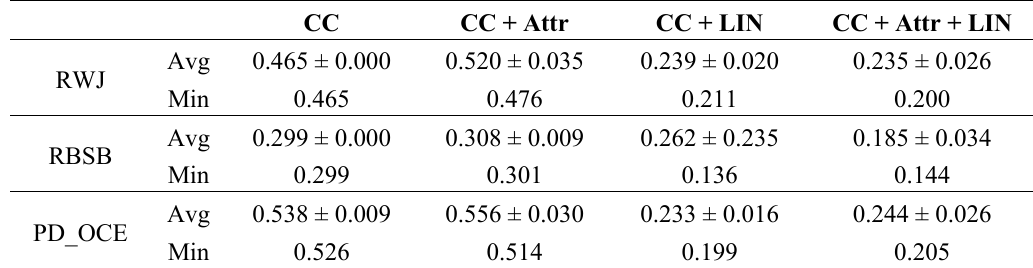
Table 8. Method performance on the Bokolmanyo problem. Note the improved results with the CC + LIN and CC + Attr + LIN method variants under all metric conditions.